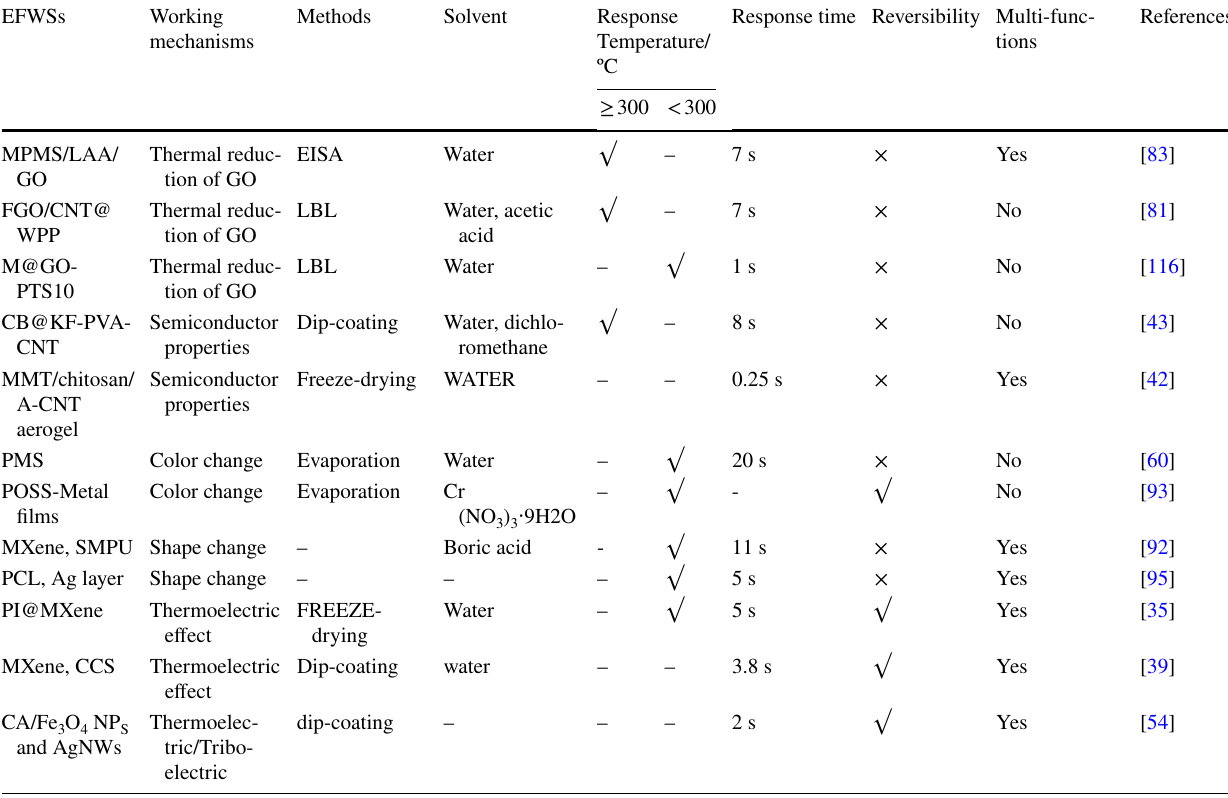
Table 1 A comparative analysis between EFWSs with different working